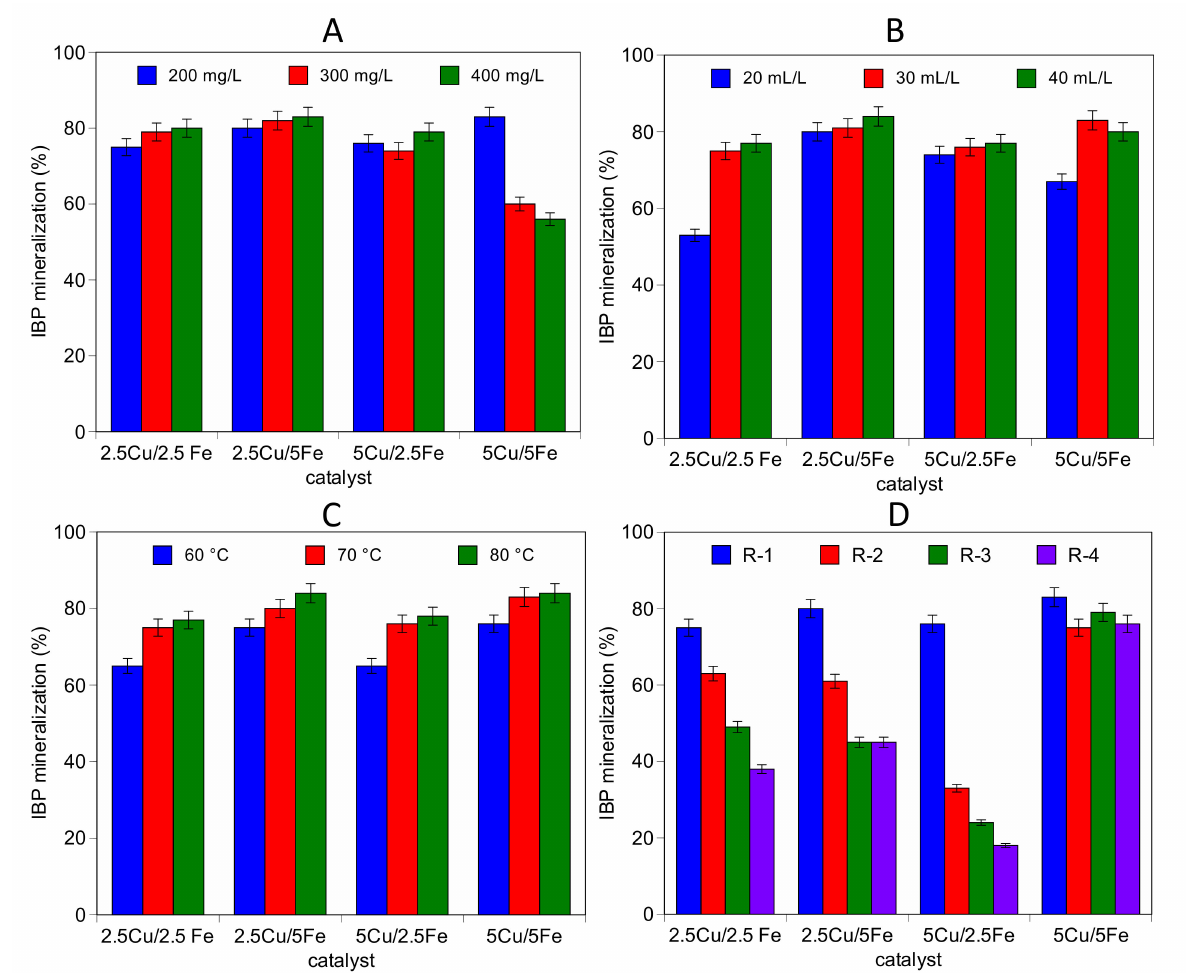
Figure 6. Effect on catalytic activity for ( A ) catalyst dose; ( B ) H 2 O 2 dose; ( C ) temperature; ( D ) catalyst recycling. (reaction condition: pH 4, reaction time 150 min; ( A ) H 2 O 2 dose—30 mL/L, 70 ◦ C; ( B ) catalyst dose—200 mg/L, 70 ◦ C; ( C ) catalyst dose—200 mg/L, H 2 O 2 dose—30 mL/L; ( D ) catalyst dose—200 mg/L, H 2 O 2 dose—30 mL/L, 70 ◦